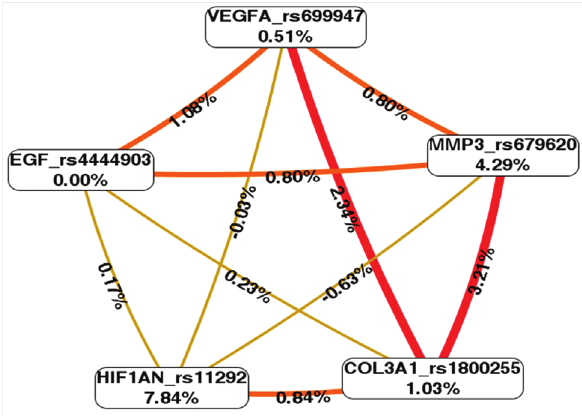
Figure 1 - Interaction map for osteoarthritis risk. The interaction model describes the percentage of the entropy (information gain) that is ex- plained by each factor or 2-way interaction. Values inside nodes indicate information gain of individual attributes or main effects, whereas values between nodes show information gain of pairwise combinations of attrib- utes or interaction effects. Positive entropy (plotted in red or orange) indi- cates interaction, which can be interpreted as a synergistic or nonadditive relationship;whilenegativeentropy(plottedingreen-yellow)indicatesin- dependence or additivity